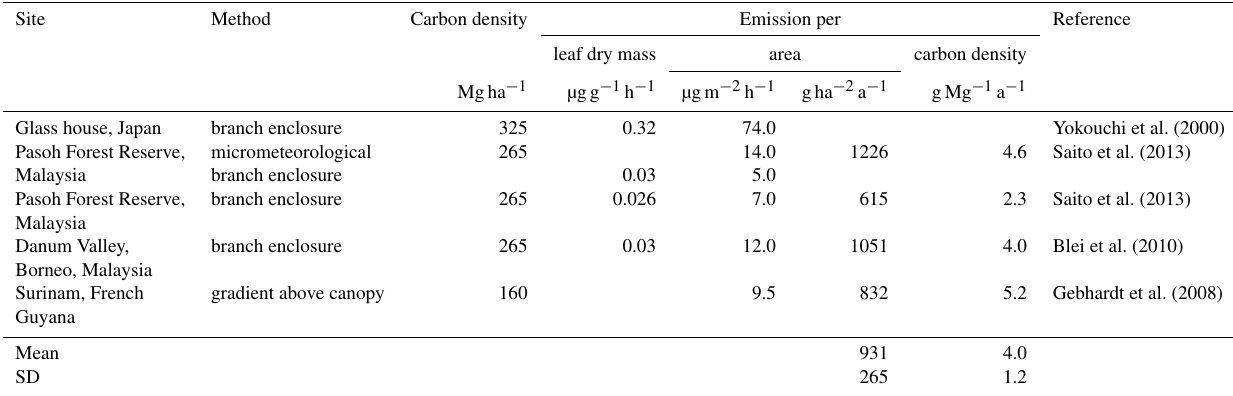
Table 5. Calculation of carbon-density-based CH 3 Cl emission factors from previously reported area-based emission factors.